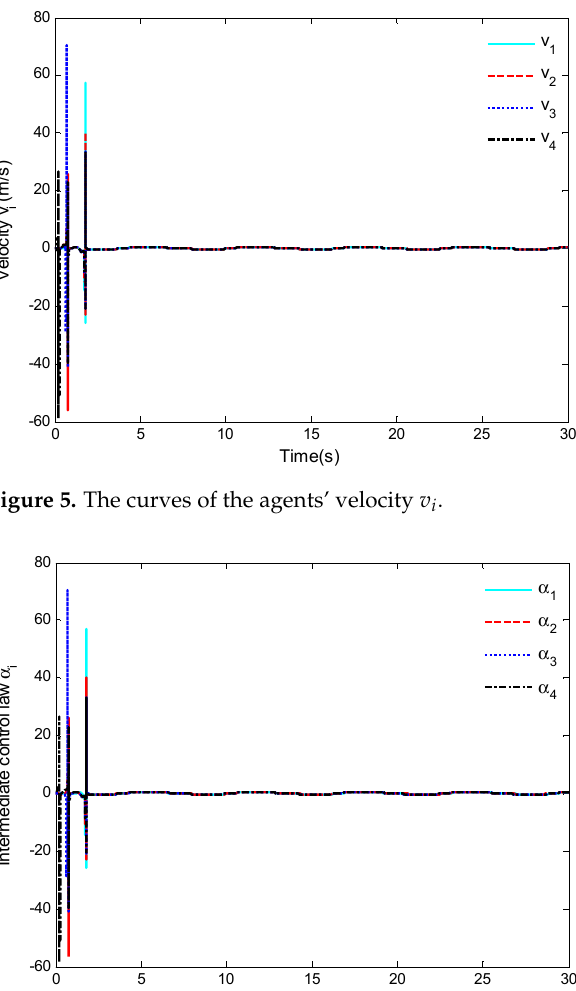
Figure 6. The curves of the intermediate control law α i .